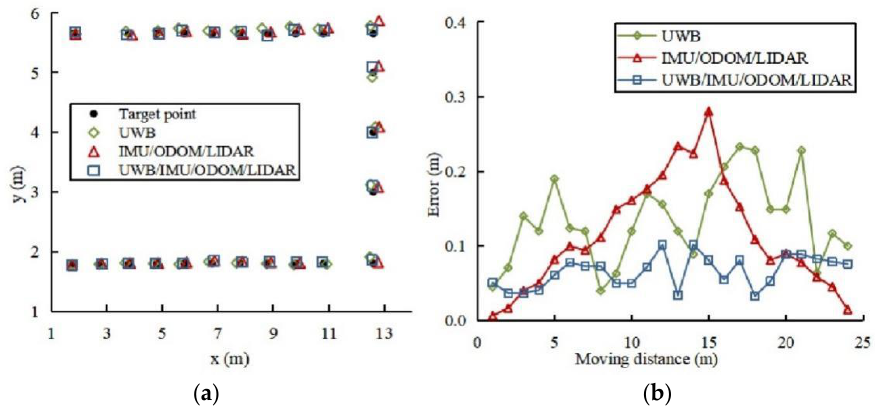
Figure 8. Different positioning methods compared for accuracy of target point positioning. ( a ) Positioning results. ( b ) Positioning error.